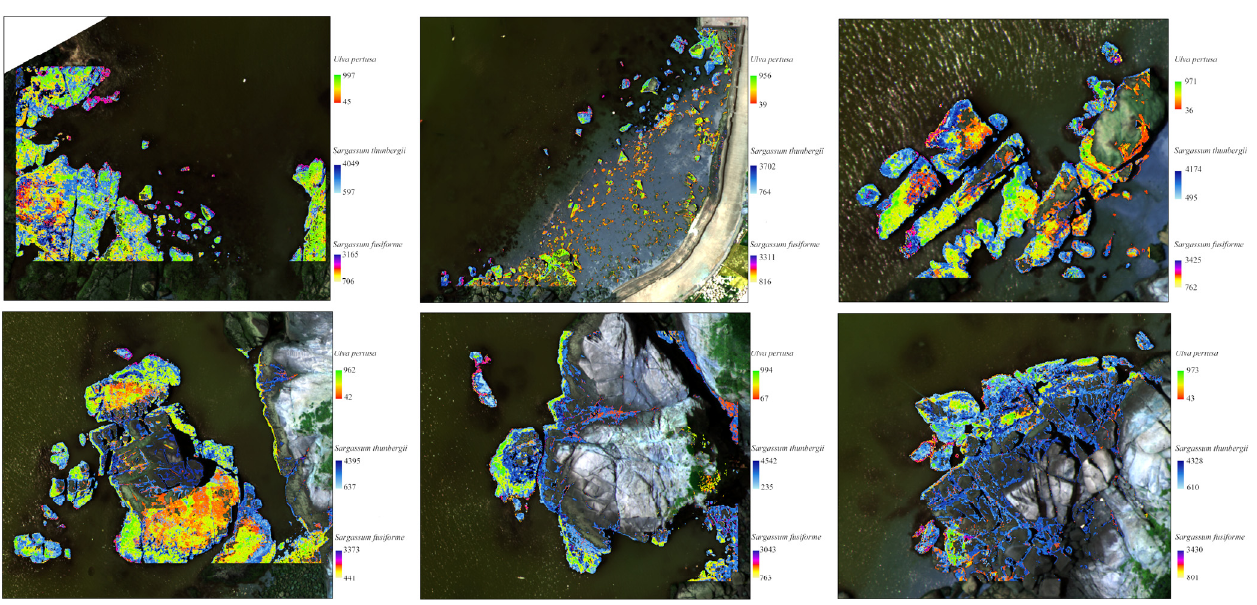
Figure 12. Biomass inversion map of three kinds of seaweed in three regions based on GBDT.